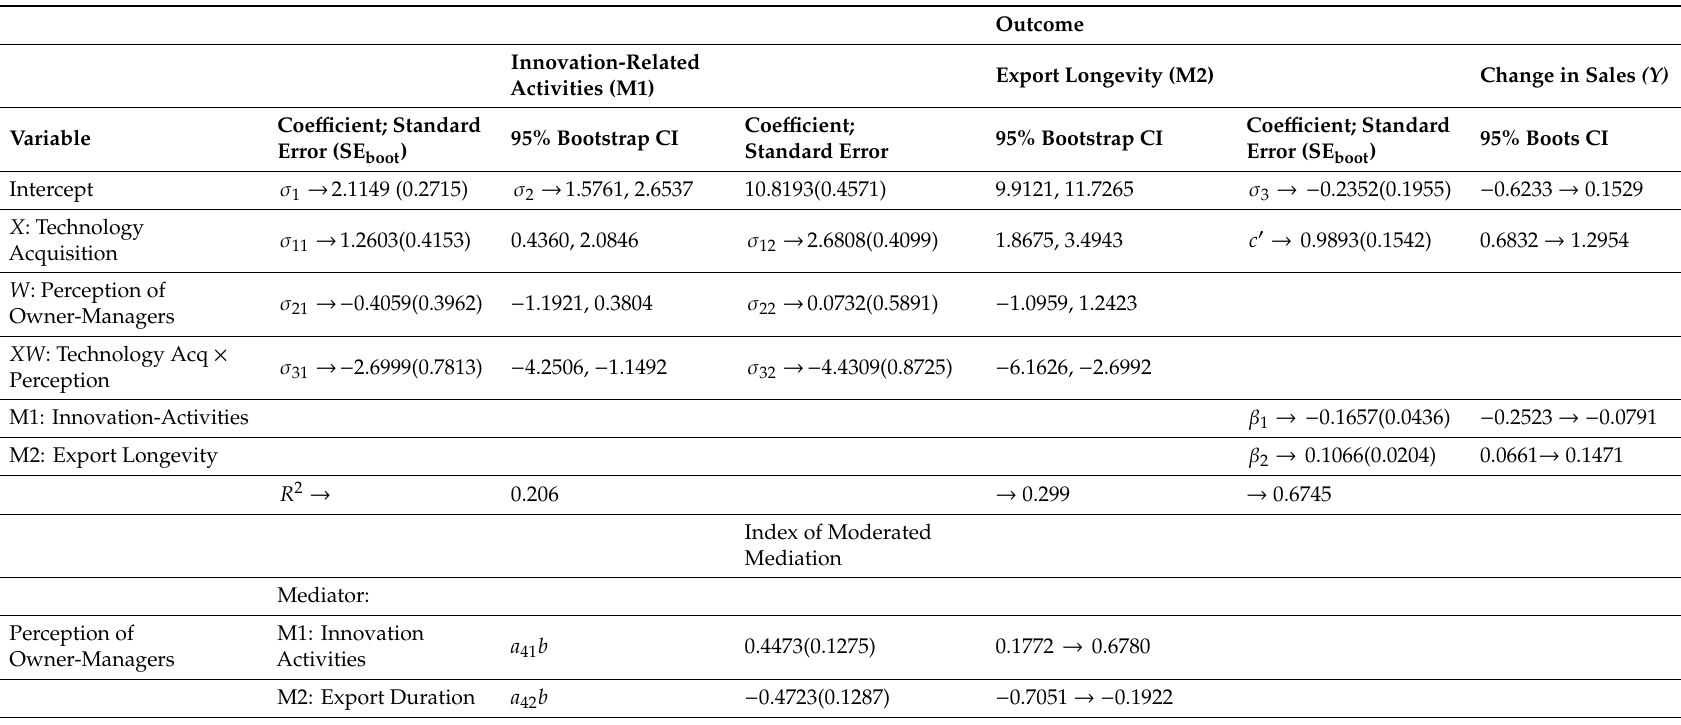
Table 3. Ordinary least squares regression results of the moderated mediated model (continuous variables